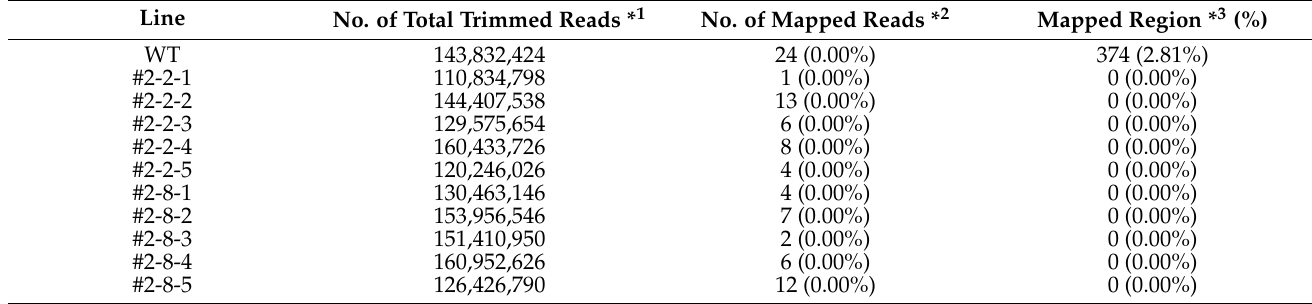
Table 4. Statistics of alignment to BrVRN1a -4gRNAs vector.